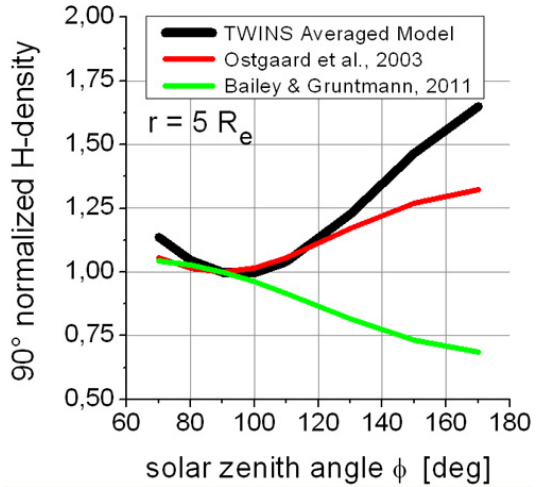
Fig. 15. Seasonal averaged TWINS H-density profile (black) at 5 R E from 90 ◦ (dusk) to 180 ◦ (midnight) in comparison to Østgaard et al. (2003) (red) and Bailey and Gruntman (2011)